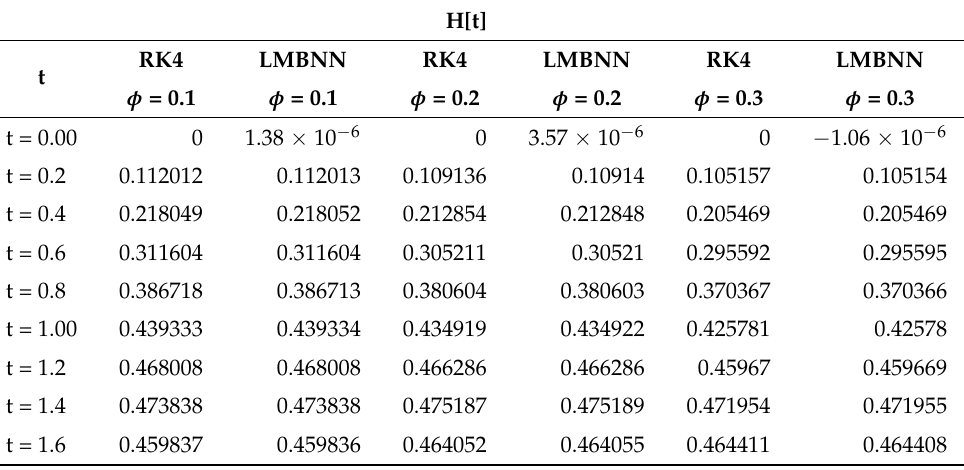
Table 12. Comparison of output data obtained through RK4 and LMBNN methods when volume fraction φ